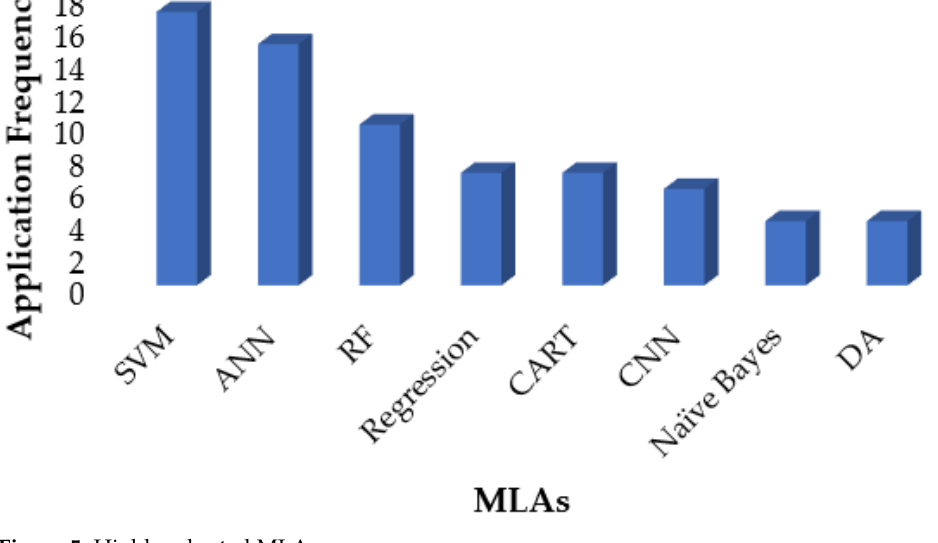
Figure 5. Highly adopted MLAs.